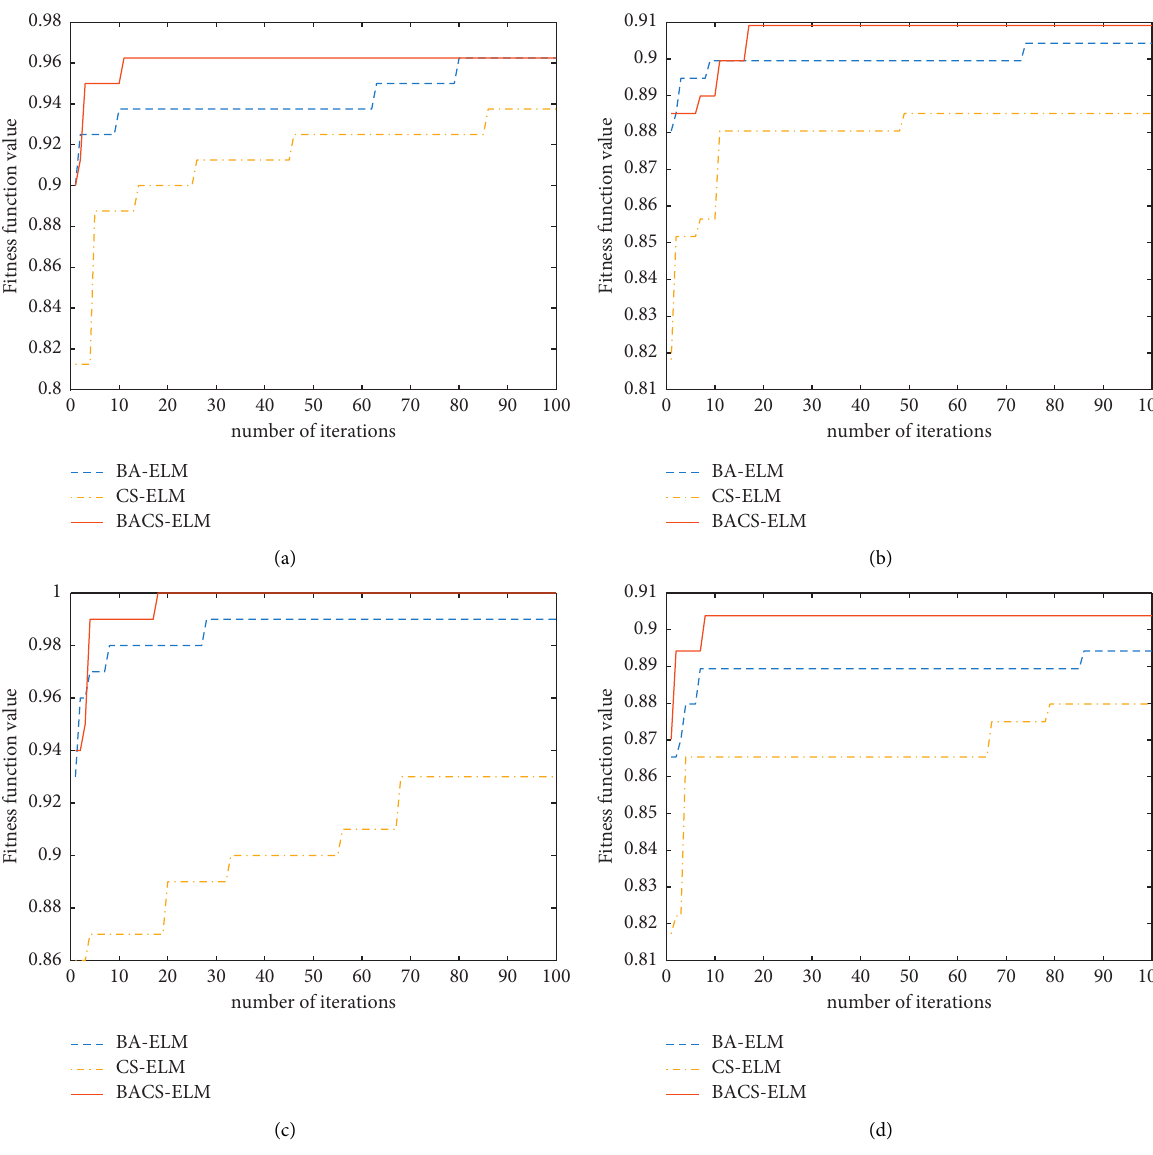
Figure 4: Comparison of fitness function curves on different datasets: (a) breast cancer; (b) heart failure; (c) iris; (d) vertebral